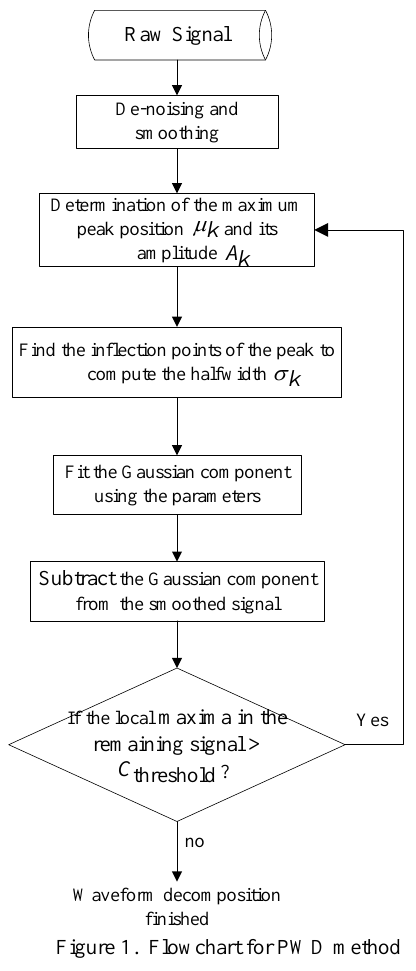
Figure 1. Flowchart for PWD method